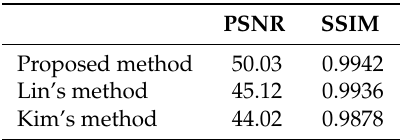
Table 4. Average PSNR and